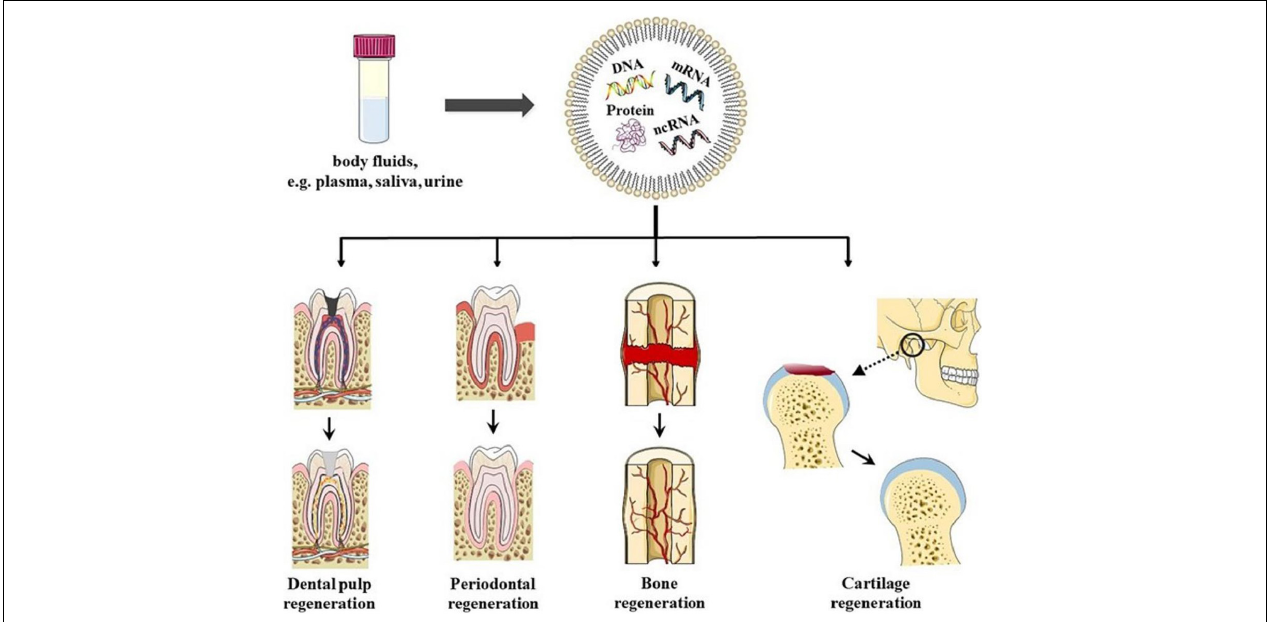
FIGURE 2 | Schematics representation of EVs in oral tissue regeneration. EVs could be found in bodily fluids, for example, plasma, saliva, and urine. EVs have been shown to have the potential to induce dental pulp regeneration, periodontal tissue regeneration, Cartilage regeneration, angiogenesis, and bone regeneration, which provides new possibilities for regeneration therapy in oral disease in the